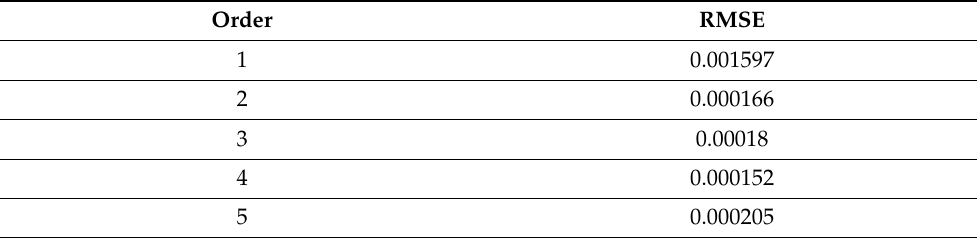
Table 2. The polynomial order used in the regression model and the corresponding root mean squared error.